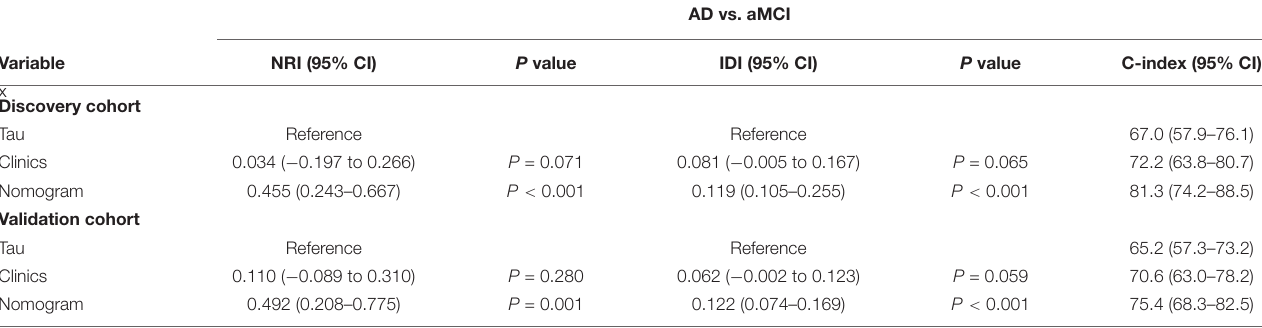
TABLE 2 | Evaluating the incremental predictive value and predictive performance of various models with NRI, IDI, and C-index between AD and aMCI.